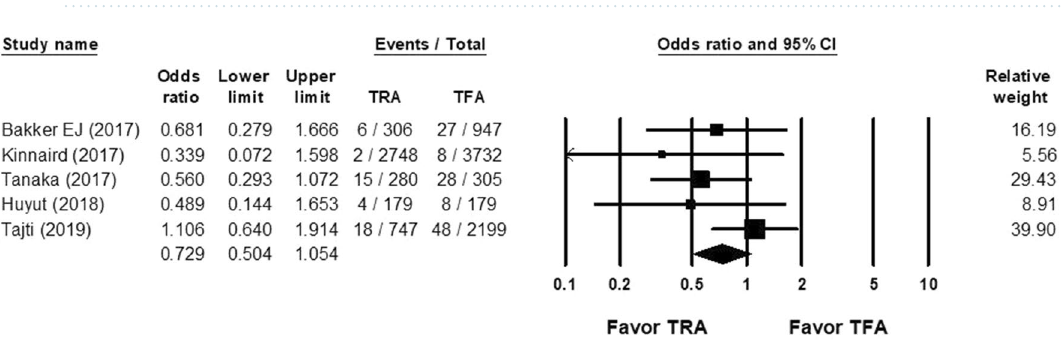
Figure 5. Forest plots of the OR of in-hospital mortality rate of CTO PCI between the TRA and TFA groups from 3 studies.